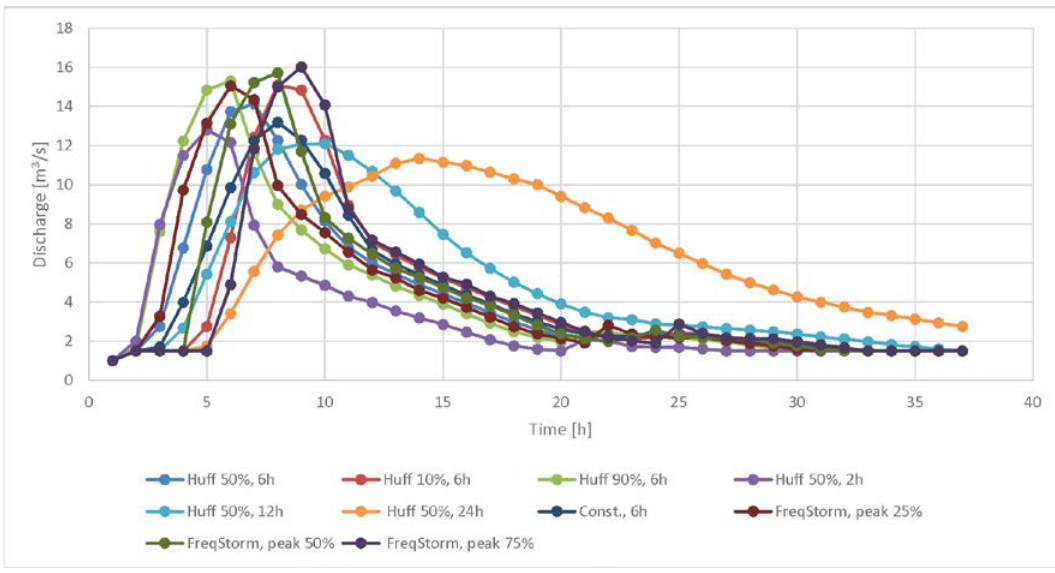
Figure 5. Comparison of outflow hydrographs for the 10 selected scenarios for the 100-year return period.